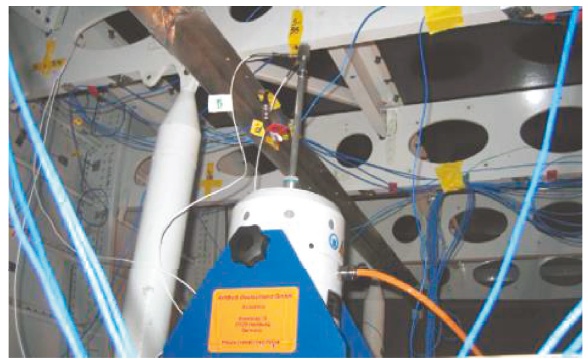
Figure 8: Internal transient impact load test